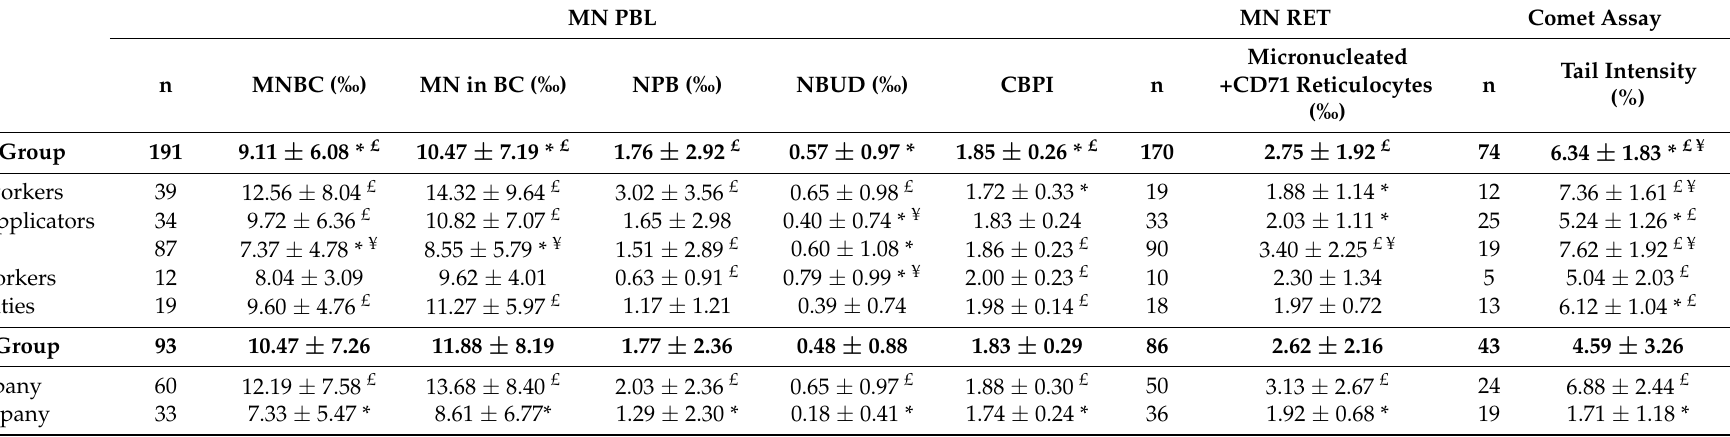
Table 2. Results of genotoxicity biomarkers that were analyzed in the blood cells from workers that were exposed to Cr(VI) and the control groups (mean ± SD). MN PBL MN RET Comet